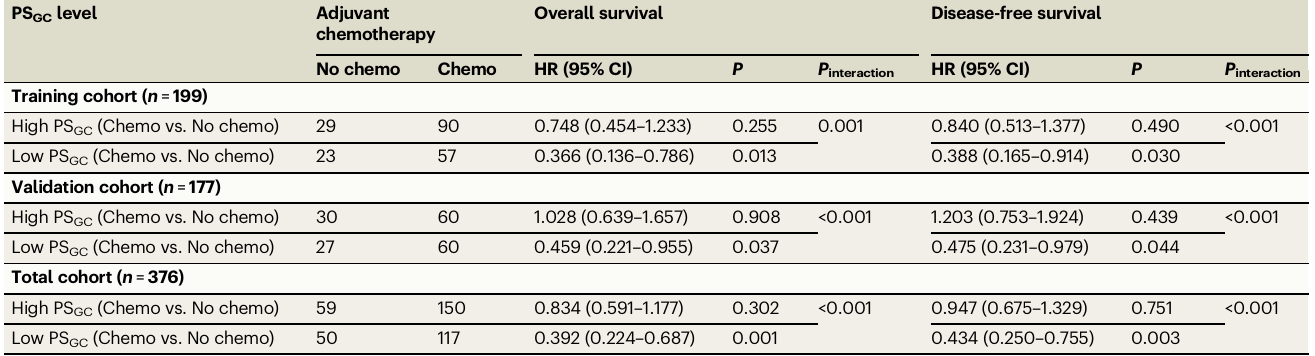
Table 3 | Association of the PS GC with overall survival and disease-free survival in stage II and III patients receiving adjuvant chemotherapy PS GC